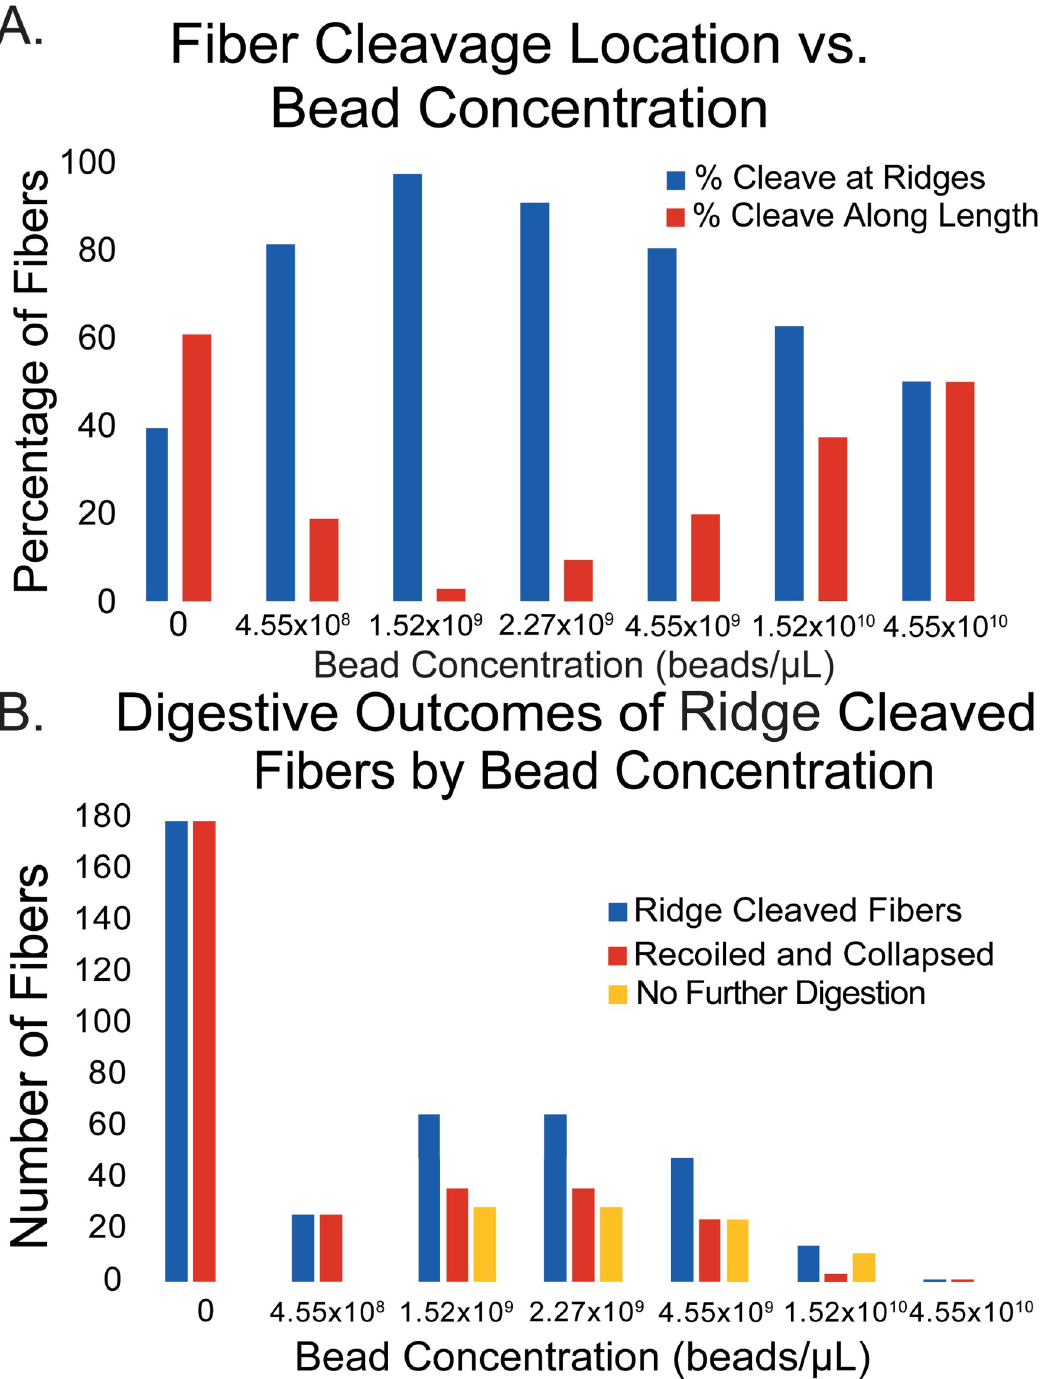
Fig 5. Cleavage location and digestive outcomes of ridge cleaved fibers. (A) The percentage of fibers that cleaved at either the fiber-ridge connection or elsewhere along the length of the fiber are presented for each bead concentration. Percentages of fibers that cleaved at the fiber-ridge connection are shown in blue, and fibers that cleaved somewhere along the length of the fiber are shown in red. (B) Of the ridge cleaving fibers, the digestive outcomes are further broken down by bead concentration. The blue bars are representative of the total number of ridge cleaving fibers at each dilution. Of this total (1.52x10 9 beads/ μ L = 65, 2.27x10 9 beads/ μ L = 65, 4.55x10 9 = 48, 1.52x10 10 beads/ μ L = 14, 4.55x10 10 beads/ μ L = 1), fibers either recoiled and collapsed (red) or showed no signs of further digestion (yellow).